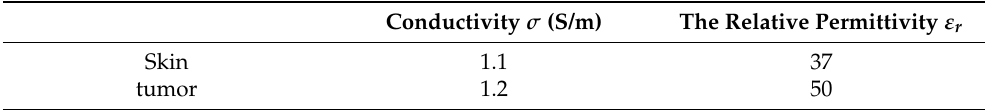
Table 1. Dielectric property and conductivity of breast and tumor